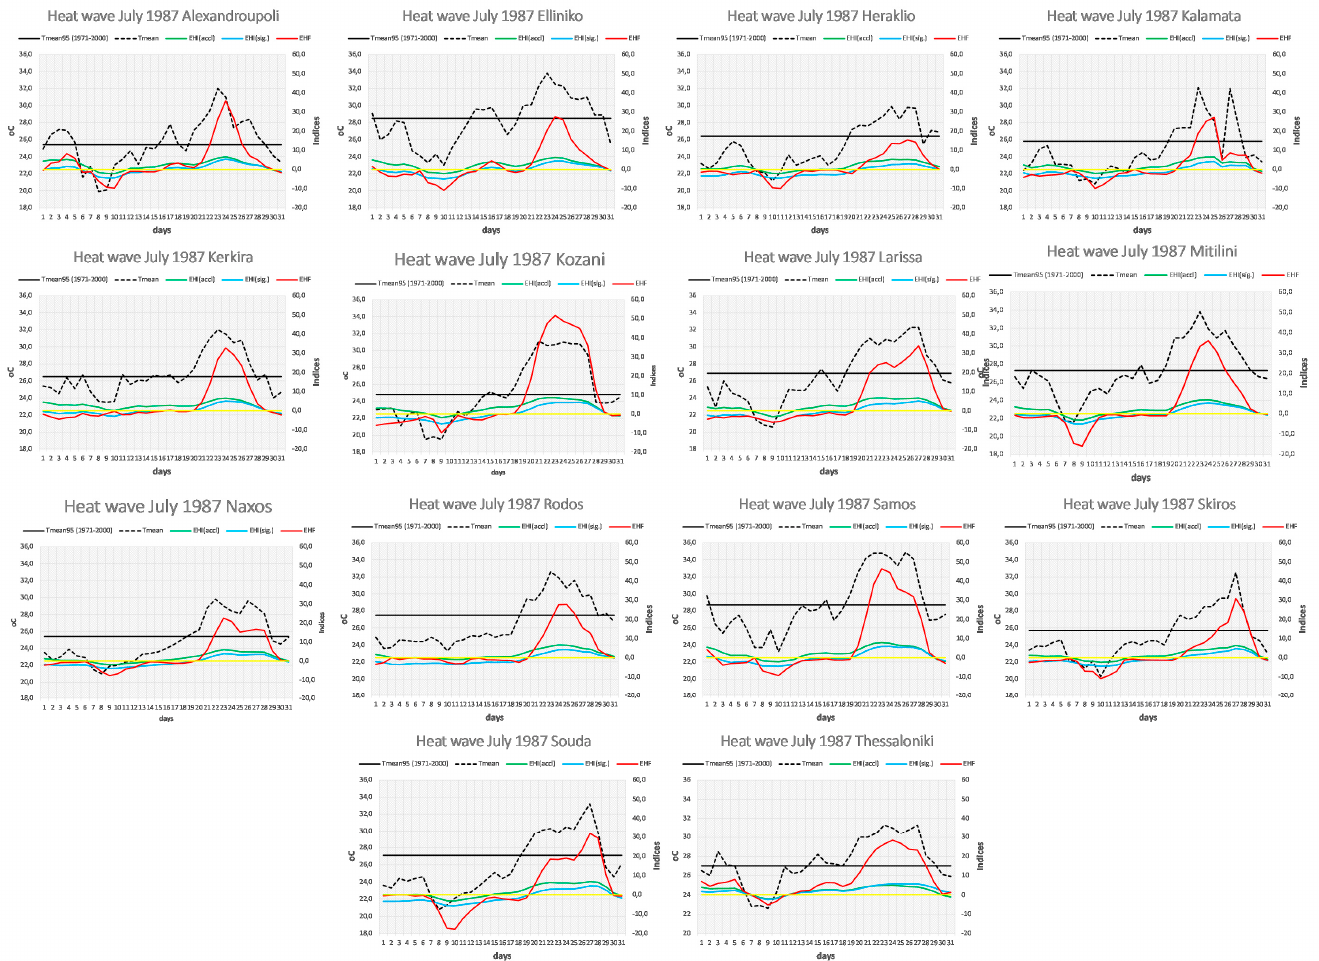
Figure 4. Day-to -day representation of the heat wave of July 1987 in Greece. The daily Tmean values as well as the Tmean95 percentile (reference period 1971–2000) are plotted in reference to the left y-axis ( ◦ C) and the three indices in reference to the right y-axis ( ◦ C). The yellow line represents zero and refers to the right